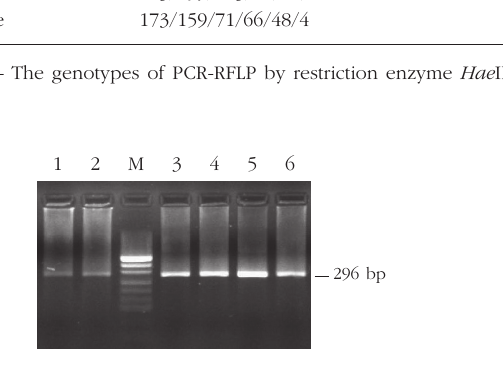
Fig 1 – Electrophoretic patterns of PCR product of the second exon of Ovar- DRB 1 in Kazakh sheep, M: PUC19 DNA marker.